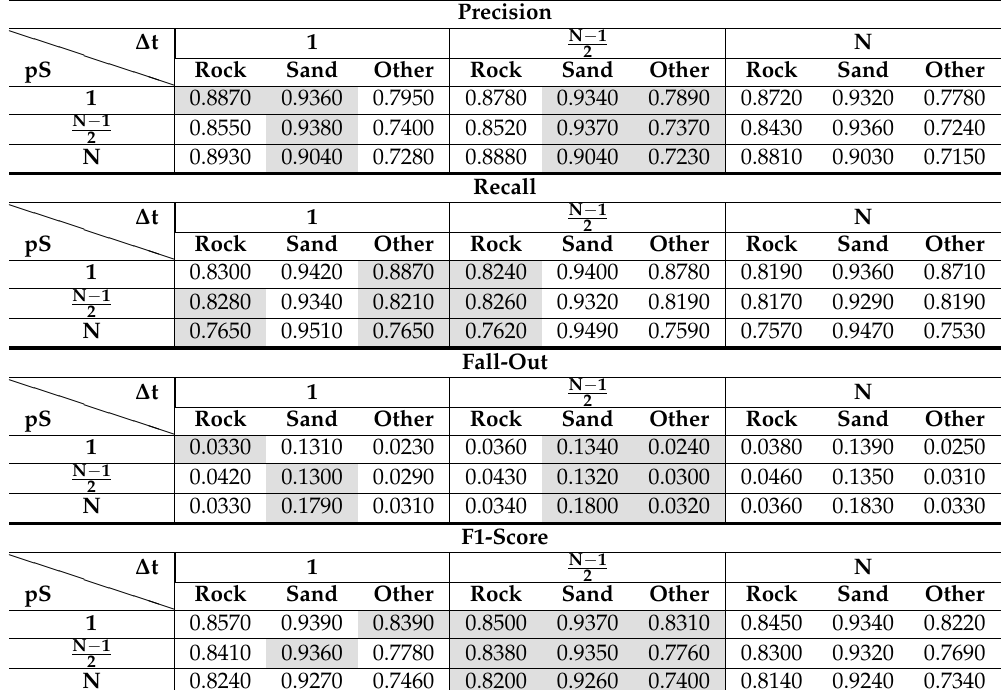
Table 7. Precision, recall, fall-out and F1-Score results when using MCM. The gray cells denote the configurations under which MCM surpasses